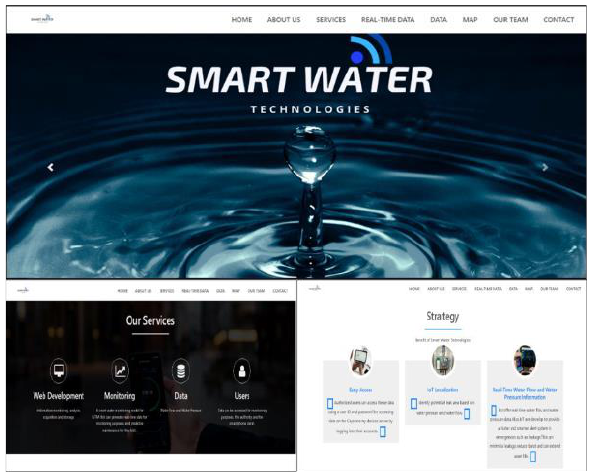
Figure 7. Homepage of the Website.